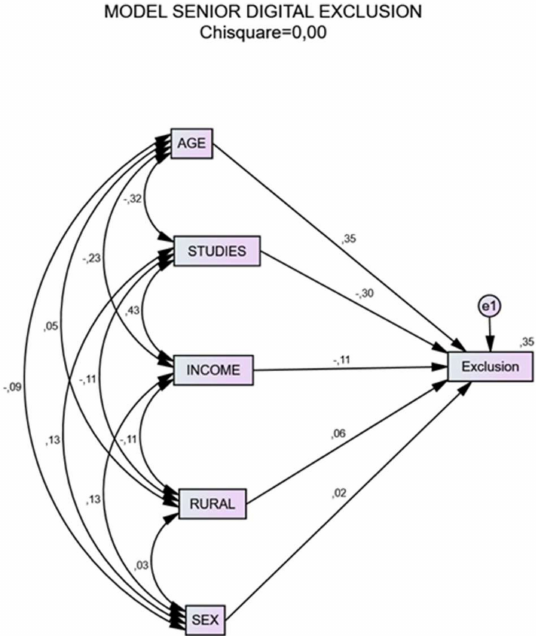
Figure 8. Model Seniors Digital